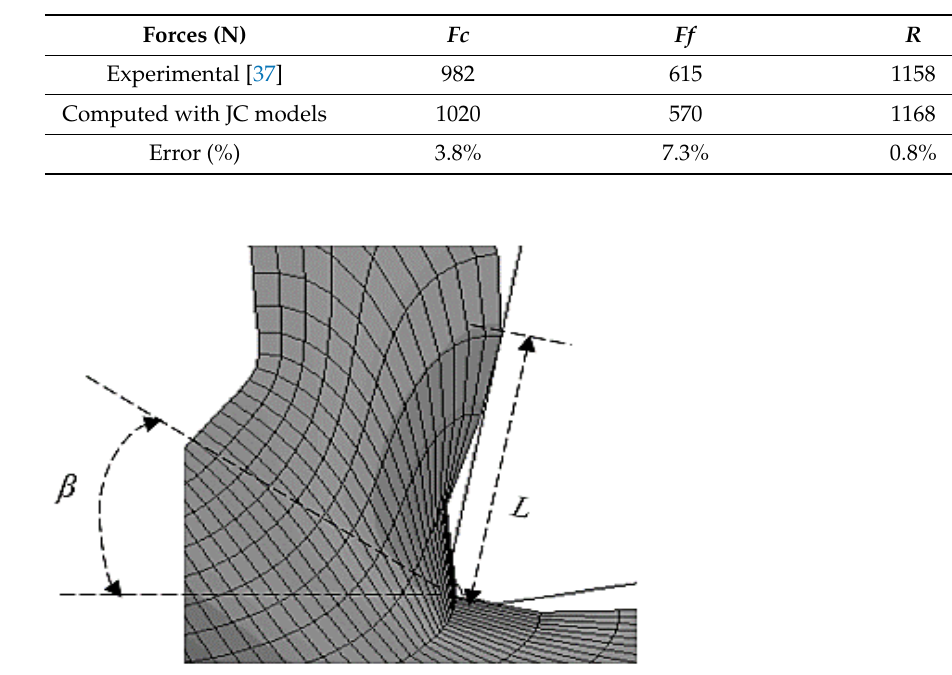
Table 10. Numerical and experimental cutting forces, Vc = 50 m/min.